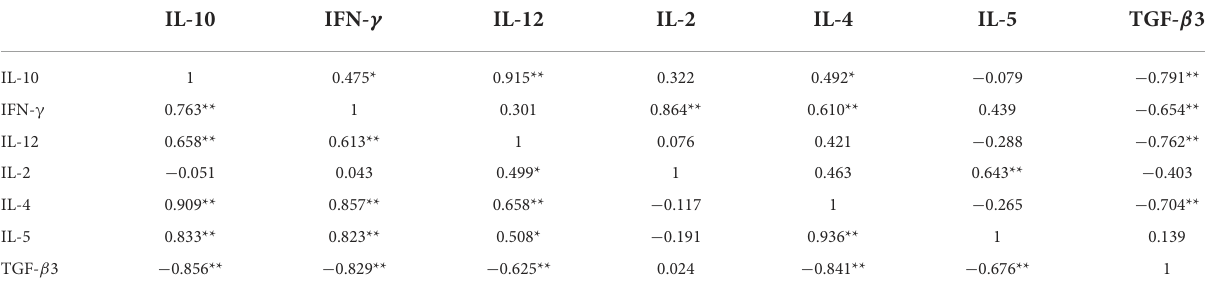
TABLE 7 Pairwise correlation coefficients between Th1/Th2/Treg cytokines in the intestine (above) and spleen (below) of pigeons experimentally infected with Prohemistomum vivax . IL-10 IFN- γ IL-12 IL-2 IL-4 IL-5 TGF- β